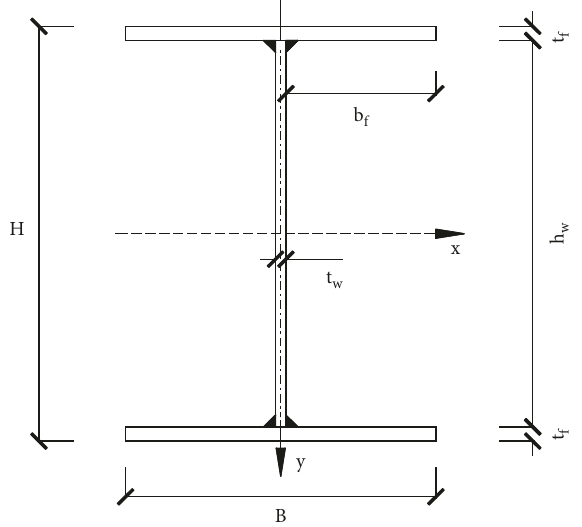
Figure 1: Geometric notation for the